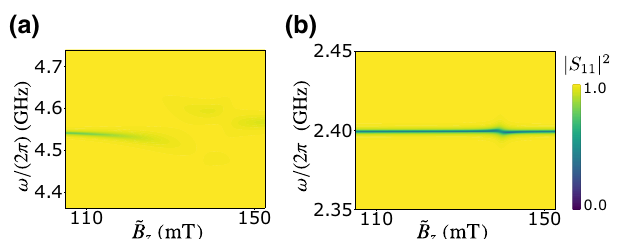
FIG. 15. Cavity-induced magnon-magnon interaction and MP hybridization of the magnetically dark elliptic mode at a larger damping rate. Calculated microwave reflection | S 11 (ω) | 2 using Eq. (H5), where D / J = 0.5, η = 0.1, κ a /( 2 π) = 1 MHz, and κ /( 2 π) = 100 MHz. The energy eigenvalues ˜ E and magnetic n fields ˜ B z are rescaled for Cu 2 OSeO 3 . Electromagnetic fields of ˆ E (cid:9) ˆ B (cid:9) [001] and [110] the cavity modes are directed in (a) FIG. 14. Cavity-induced magnon-magnon interaction at off- ˆ B (cid:9) ˆ E (cid:9) at (cid:3)/( 2 π) = 4.55 GHz and (b) [110] and [001] at resonance microwave frequencies. (a),(b) Magnetic field depen- (cid:3)/( 2 π) = 2.4 GHz. The direction of static magnetic fields is dence of the magnon-photon spectrum of the low-temperature fixed as ˆ z (cid:9) [001]. We choose the same range of magnetic fields SkX at k = 0, where D / J = 0.5, η = 0.1, κ a /( 2 π) = 1 MHz, and frequencies as in Figs. 4(b) and 4(d) of the main text for (a) ˜ E and magnetic and κ n /( 2 π) = 20 MHz. The energy eigenvalues and (b), respectively. The SkX is assumed to be placed slightly fields ˜ B z are rescaled for Cu 2 OSeO 3 . The color code indicates away from the antinode of the electric component of the cavity the probability density of the cavity mode (dark yellow) and the mode with | B | ≈ 0.1 B 0 and | E | ≈ 0.995 E 0 [see Eq. breathing (magenta) and CCW (cyan) modes. Planck’s constant is denoted as h . (c),(d) Calculated microwave reflection | S 11 (ω) | 2 using Eq. (H5). In all panels, electromagnetic fields of the cav- ˆ E (cid:9) ˆ B (cid:9) [001] and [110] with (a),(c) ity modes are directed in (cid:3)/( 2 π) = 4.4 GHz and (b),(d) (cid:3)/( 2 π) = 4.7 GHz. The direc- tion of static magnetic fields is fixed as ˆ z (cid:9) [001]. The SkX is assumed to be placed slightly away from the antinode of the electric component of the cavity mode with | B | ≈ 0.1 B 0 and | E | ≈ 0.995 E 0 [see Eq. (H6)].